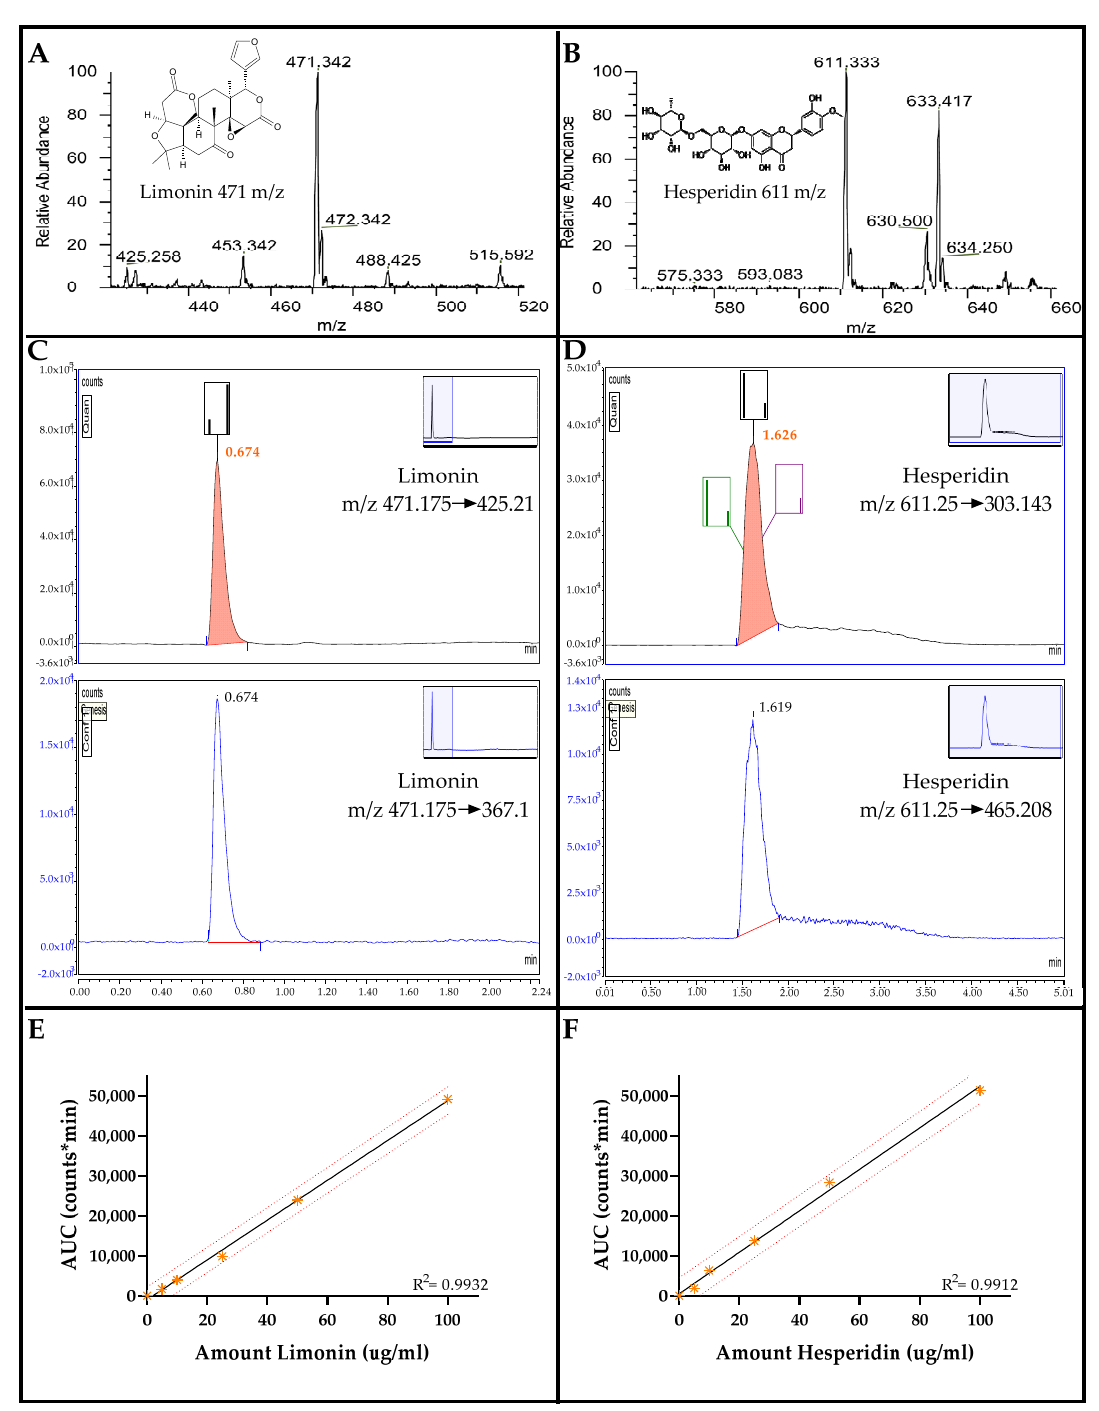
Figure 1. Reference compounds analyzed by UHPLC-MS/MS. Precursor MS spectra of limonin ( A ) and hesperidin ( B ). Chromatograms for quantified (upper) and confirmed (lower) product ions of limonin ( C ) and hesperidin ( D ). Retention times are shown as a red number above the quantified peaks. Average calibration curves of limonin ( E ) and hesperidin ( F ) generated by the linear plots between areas under the curves of the quantitative product ions and the concentrations of standard solutions. R 2 values were obtained from linear regression.